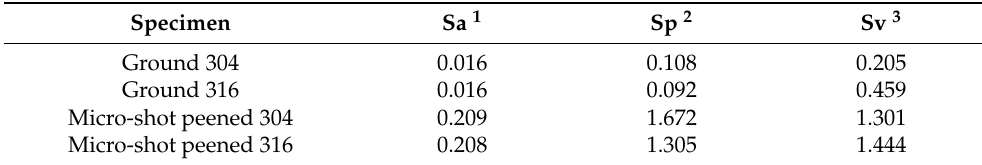
Table 1. The roughness values (unit: µ m) of ground and micro-shot peened samples measured by a 3D optical profiler.